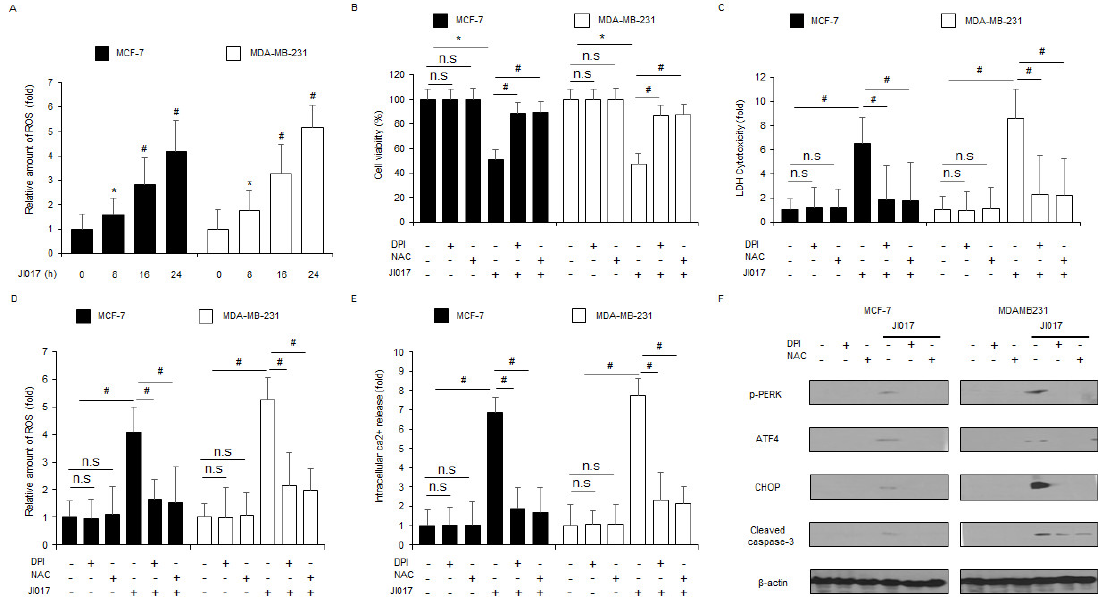
Figure 4. ROS inhibition by DPI or NAC blocks JI017-induced ER stress and cell death in breast cancer cells. ( A ) The fluorescence data indicates intracellular ROS production by DCFDA dye in JI017 (0, 8, 16, and 24 h; 300 µg/mL)-treated MCF-7 and MDA-MB-231 cells; *, p < 0.05, #, p < 0.01. ( B – F ) MCF-7 and MDA-MB-231 cells were pretreated with DPI (1 µM) and NAC (100 µM) for 4 h and subsequently treated with JI017 (300 µg/mL, 24 h). Then, WST-1, LDH cytotoxicity assay, ROS assay, intracellular Ca 2+ assay, and Western blotting analyses were performed; *, p < 0.05, #, p < 0.01. ( F ) Western blot showing p-PERK, ATF4, CHOP, and cleaved caspase-3 levels was performed using these samples. β-actin was used as the protein loading control.